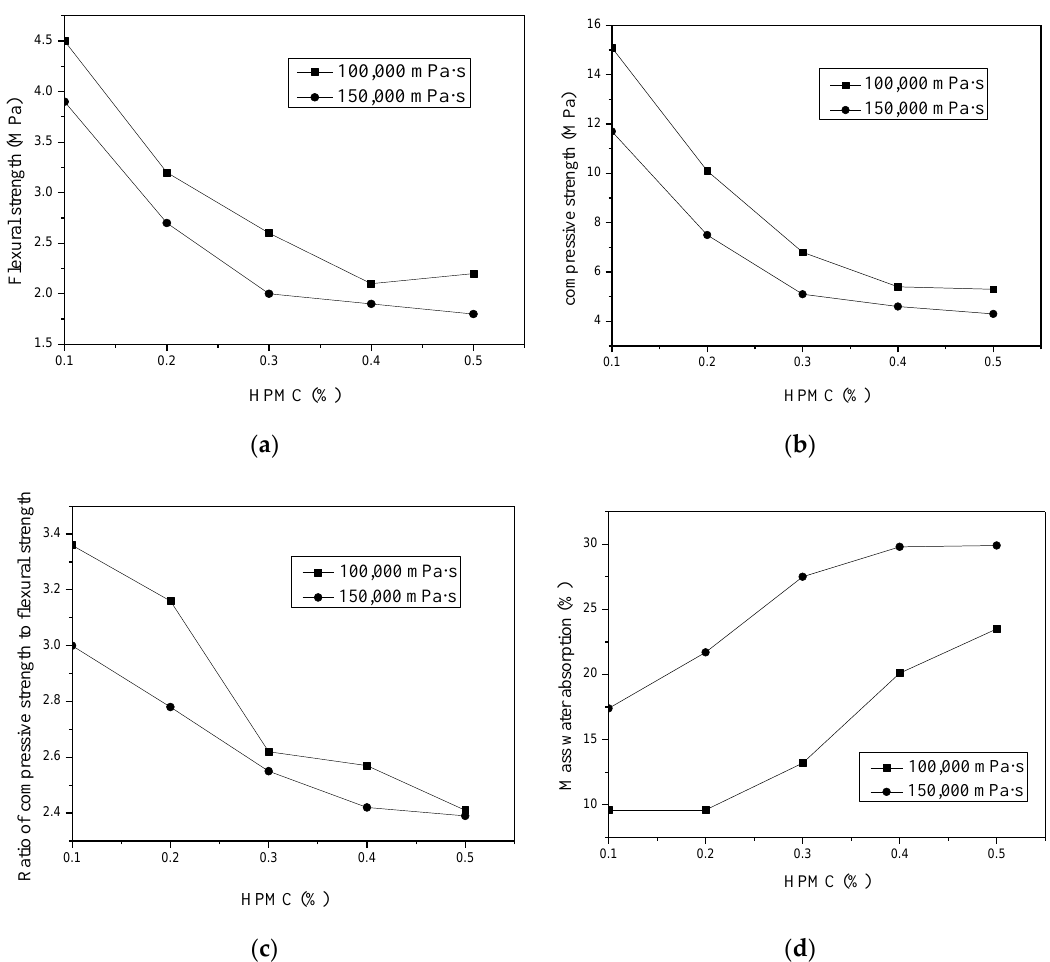
Figure 10. Effect of HPMC on the properties of the mortar. ( a ) Flexural strength; ( b ) compressive strength; ( c ) the compressive strength-to-flexural strength ratio; ( d ) water absorption.